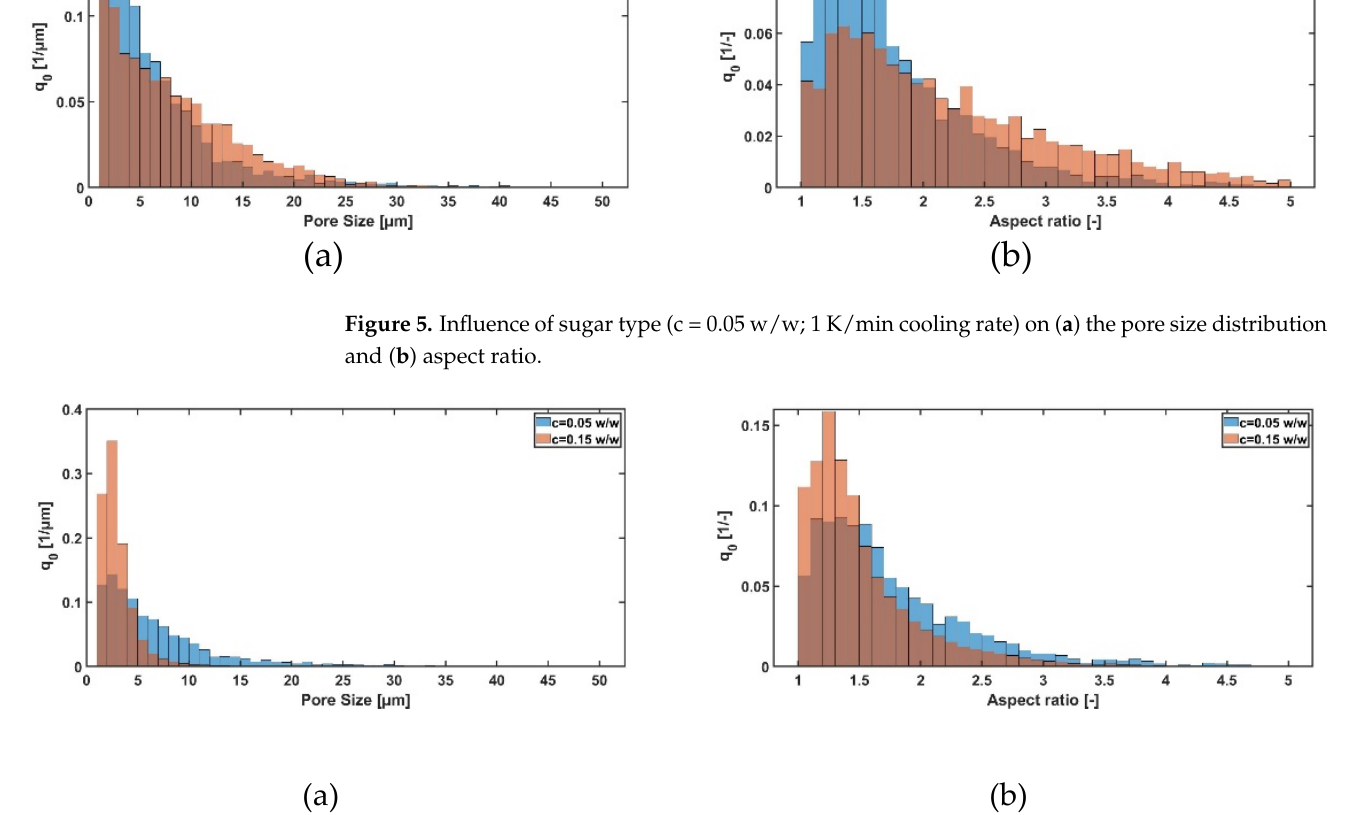
Figure 6. Influence of different solid concentration for a maltodextrin solution (1 K/min cooling rate) on ( a ) the pore size distribution and ( b ) aspect ratio.